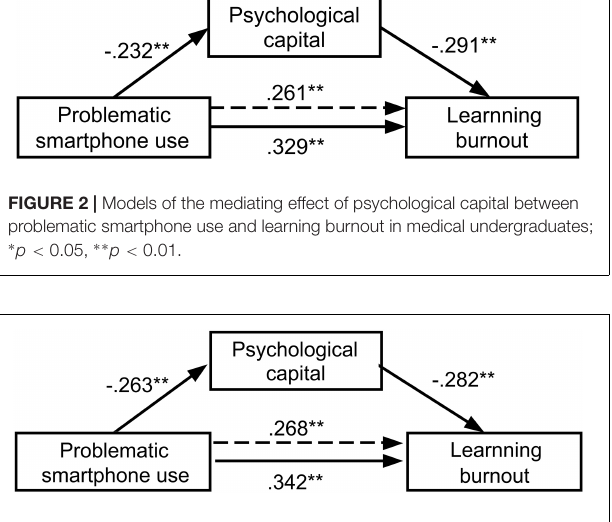
FIGURE 3 | Models of the mediating effect of psychological capital between problematic smartphone use and learning burnout in medical postgraduates; ∗ p < 0.05, ∗∗ p <